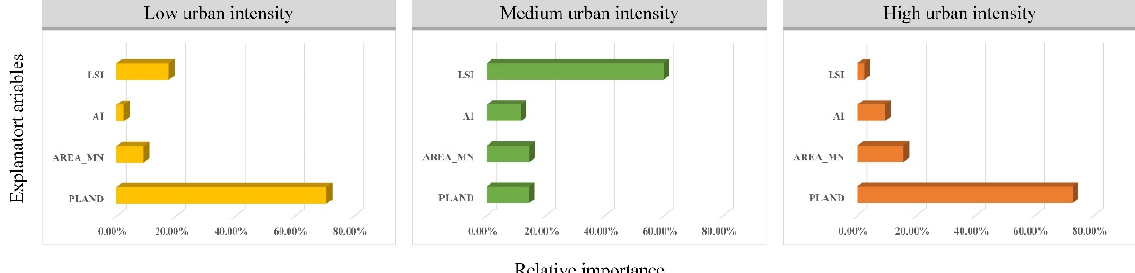
Figure 7. Relative contribution of different drivers to regional heat island intensity variation (relative importance, %) at low, medium, and high urban intensity levels. LSI, landscape shape index; AI, aggregation index; AREA_MN, mean patch area; PLAND, percent of landscape.